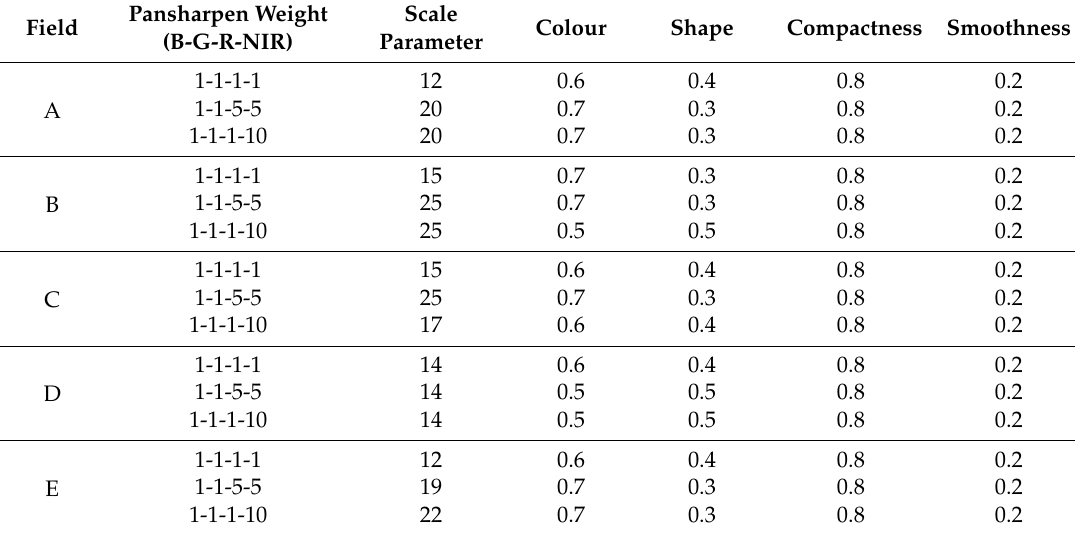
Table 3. Most satisfactory segmentation parameters obtained for each pansharpened